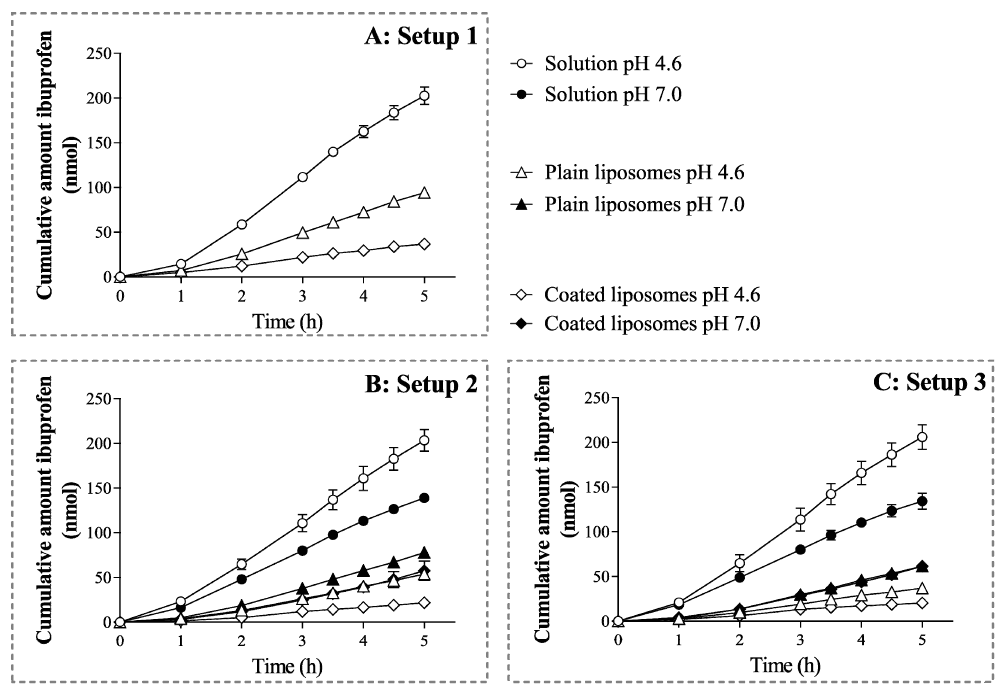
Figure 2. Cumulative amount of ibuprofen permeated across the barriers using ( A ) Setup 1 (i.e., naked barriers), ( B ) Setup 2A and 2B (i.e., mucus pH 4.6 or 7.0), and ( C ) Setup 3A and 3B (i.e., mucus + simulated vaginal fluid (SVF) pH 4.6 or 7.0) from ibuprofen solution (circle symbol, o), plain liposomes (triangle symbol, ∆ ), or coated liposomes (diamond symbol, ♦ ). Empty symbols indicate pH 4.6 and full symbols indicate pH 7.0. (Mean ± SD, n = 18).